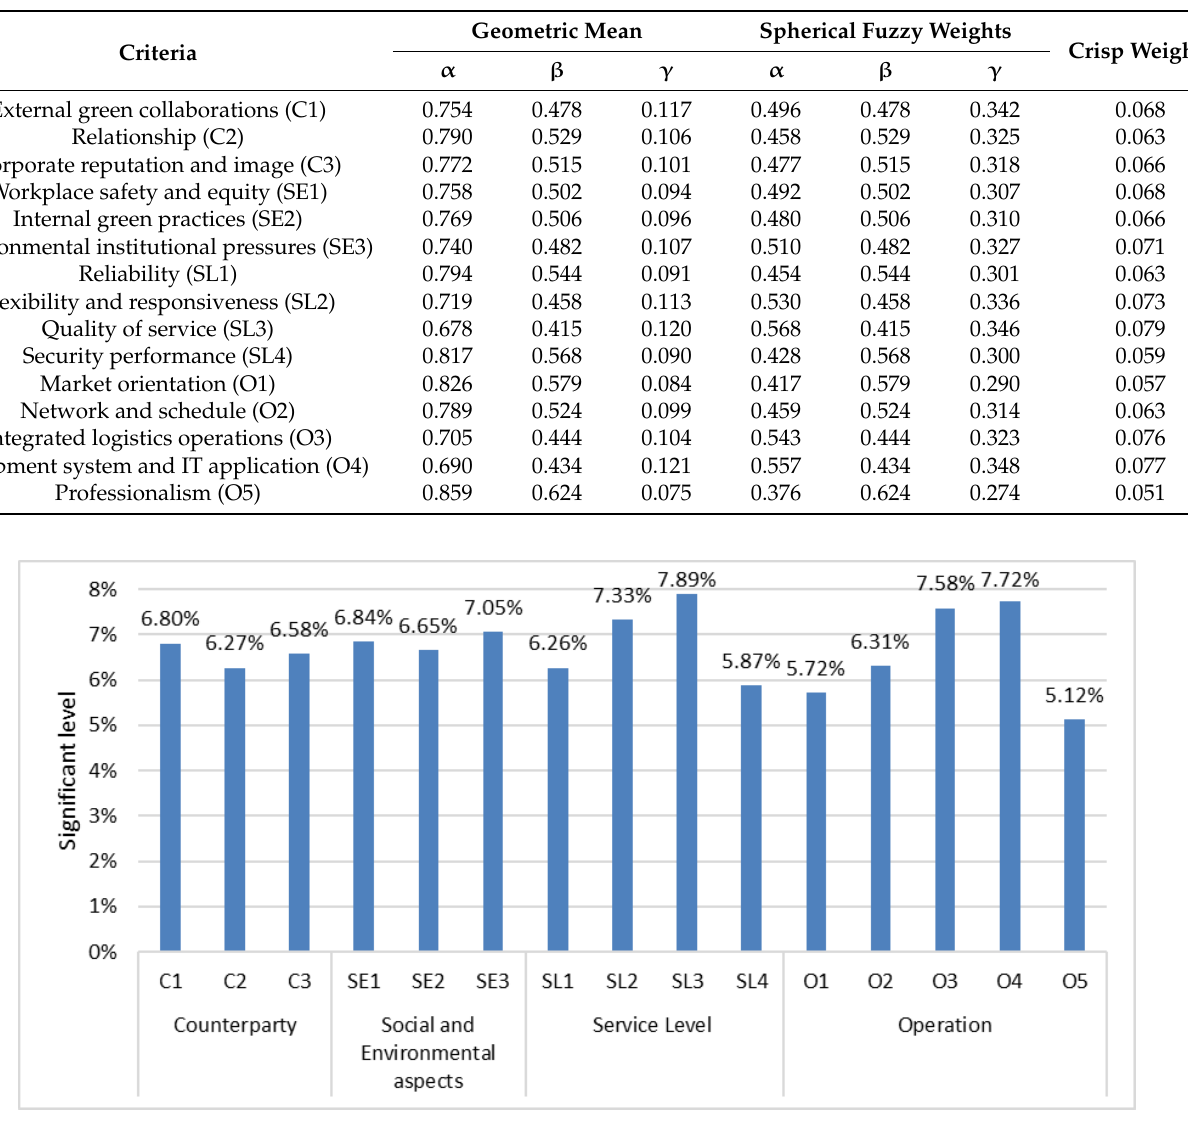
Table 12. Spherical fuzzy weights and crisp weights 15 criteria of the AHP-SF model.